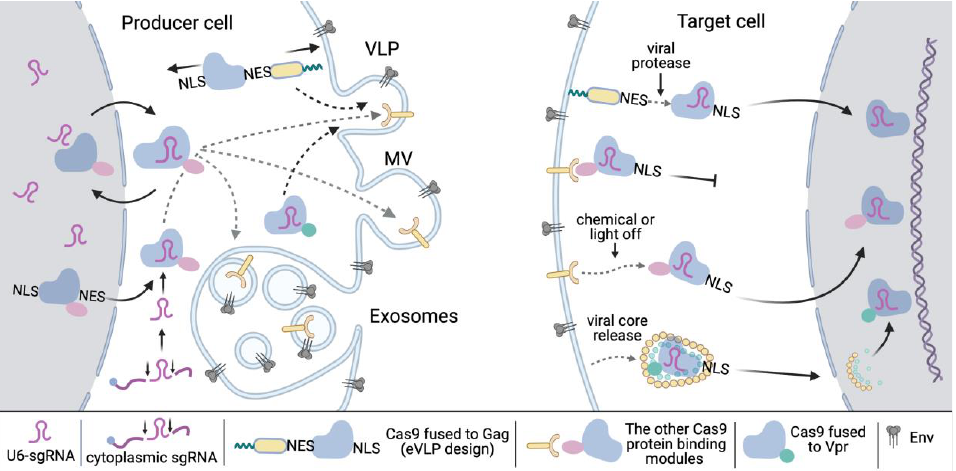
Figure 4. The mechanisms of Cas9 RNP recruitment into VLPs and EVs (on the left) and release in target cells (on the right) used by different delivery systems. The arrows indicate intracellular movements of the molecular complexes. The potential problems related to these mechanisms are schematically shown as well and include the nuclear localization of sgRNA and Cas9 in producer cells, the nonspecific incorporation of Cas9 into MV, exosomes, or VLPs, and opposing localization signals in hybrid molecules. In target cells, there can be no specific mechanism of Cas9 RNP release into the cytoplasm and trafficking to the nucleus or unclear mechanism of Ca9-Vpr viral core disassembly. The image is created with